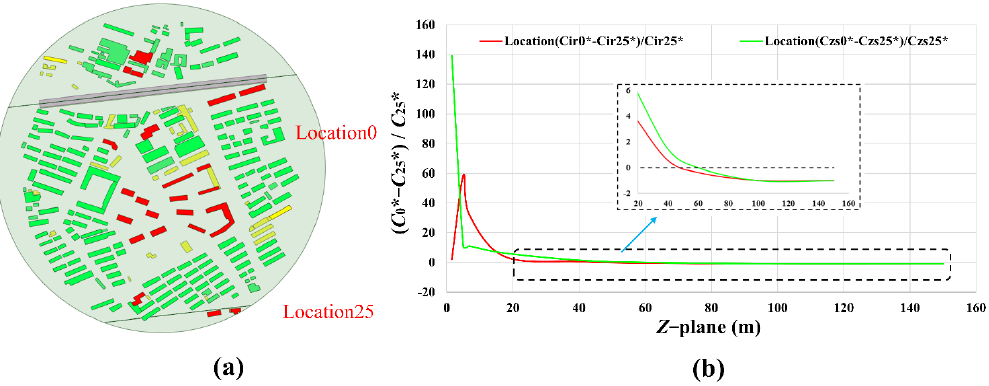
Figure 11. Location and normalized pollutant concentration ( C *): ( a ) Location of pollutant; ( b ) Ratio of ( C 0 * – C 25 *)/ C 25 *.